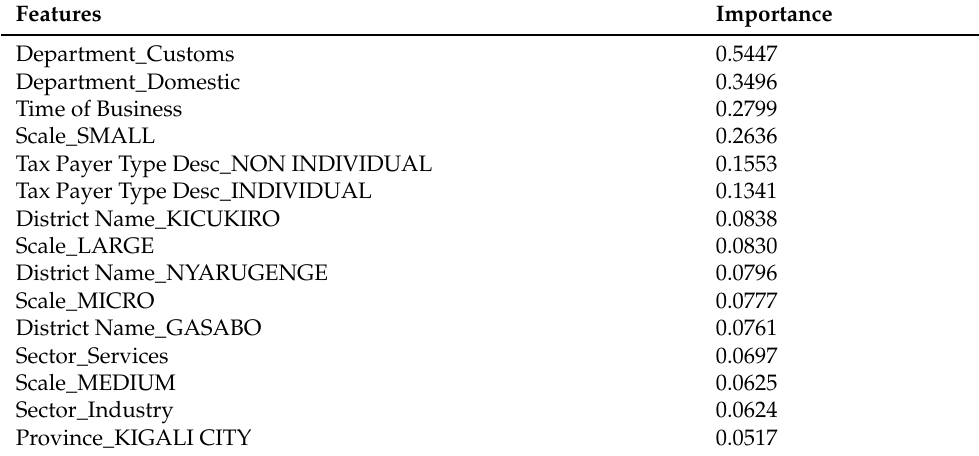
Table 3. Feature